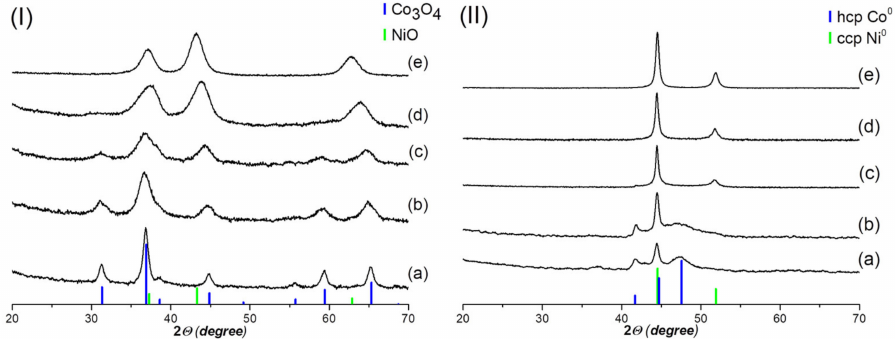
Figure 1. XRD patterns of obtained Co-Ni-containing systems after calcination ( I ) and reduction ( II ): Co_W8 ( a ); Co2Ni1_W8 ( b ); Co1Ni1_W8 ( c ); Co1Ni2_W8 ( d ); Ni_W8 ( e